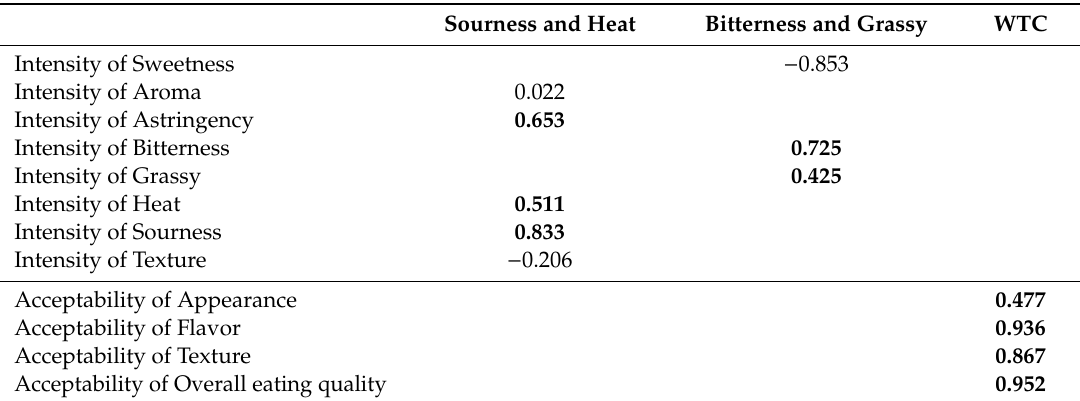
with absolute values around | 0.30 | indicate a “medium” e ff ect; *** significant at p < 0.001. Table 4. Measurement model of the PLS-SEM involving the nine sensory attributes of 12 microgreens species. Factor loadings indicate the correlation between the attribute and the latent construct.